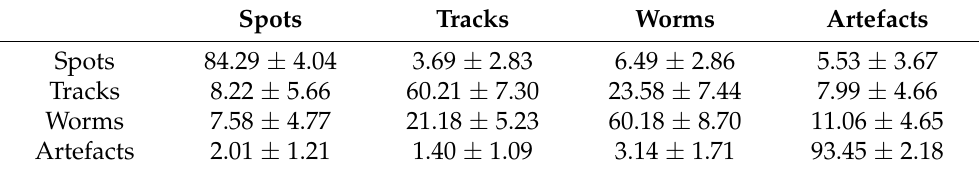
Table 6. Confusion matrix of network with input convolutional Xception architecture. Spots Tracks Worms